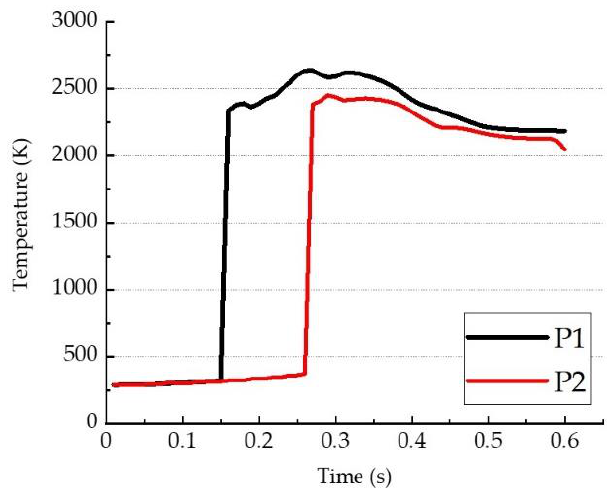
Figure 7. Temperature results of P1 and P2 in the chamber.